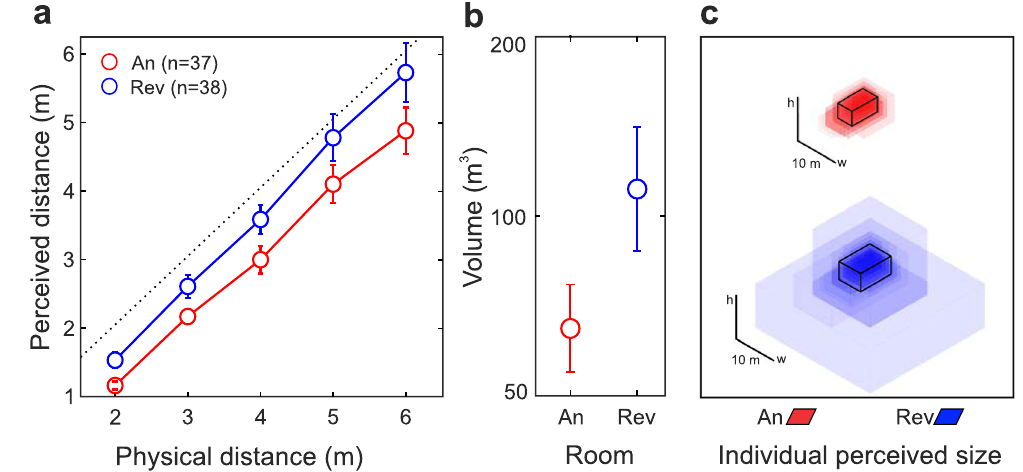
Figure 2. Results of Experiment 1: ( a ) Visual distance perception curves for both rooms in Experiment 1. We show mean responses ( ± SEM) as a function of target distance: anechoic chamber (An) in red and reverberant room (Rev) in blue. The black dotted line indicates perfect performance. ( b ) Mean perceived volume ( ± SEM) for each room. ( c ) Each transparent box corresponds to the individual perceived dimensions (width, length and height) for each condition (anechoic chamber: upper section, in red; reverberant room: lower section, in blue). For each room, the box in solid black lines represents the average of each dimension (taken separately) across